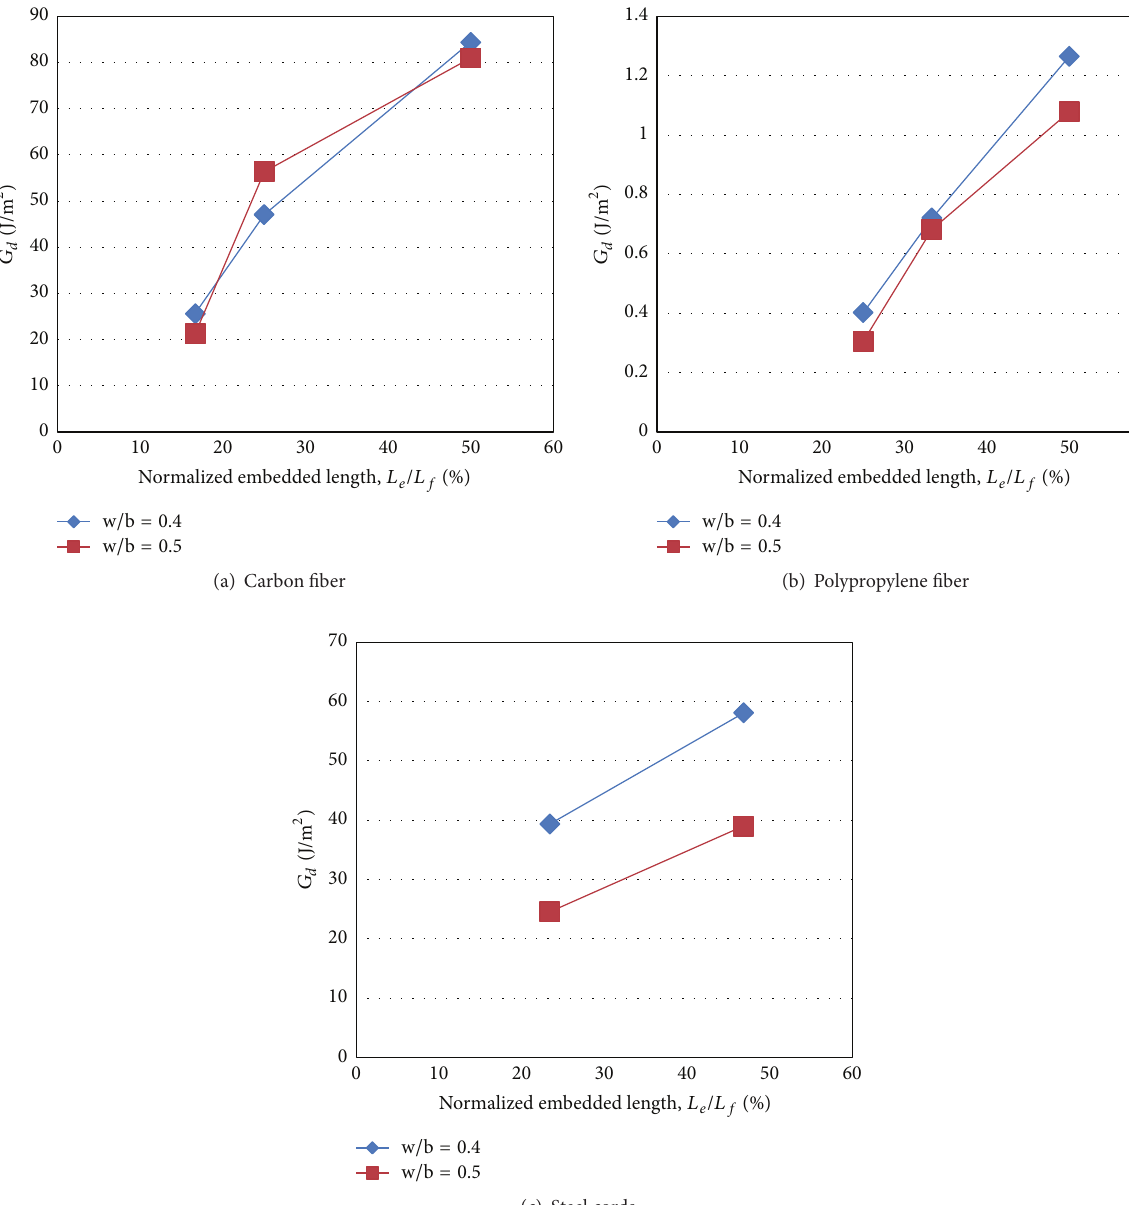
Figure 10: Chemical bond stress ( 𝐺 𝑑 ) with respect to normalized embedment length ( 𝐿 𝑒 /𝐿 𝑓